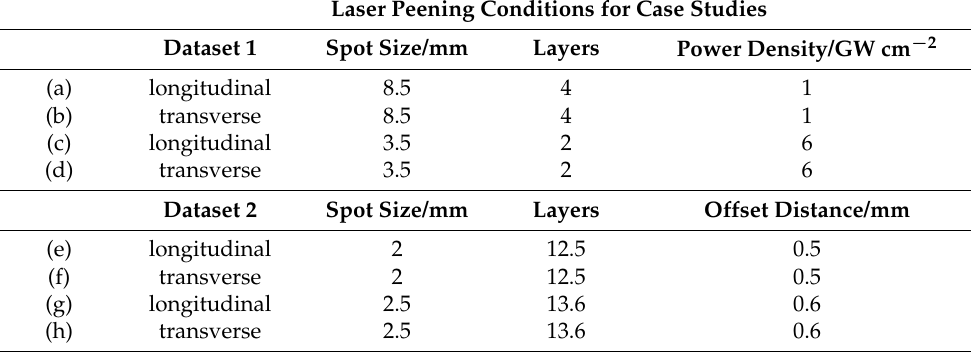
Table 6. Process parameters used for case studies using neural network prediction model using a ‘leave-one-out’ cross validation